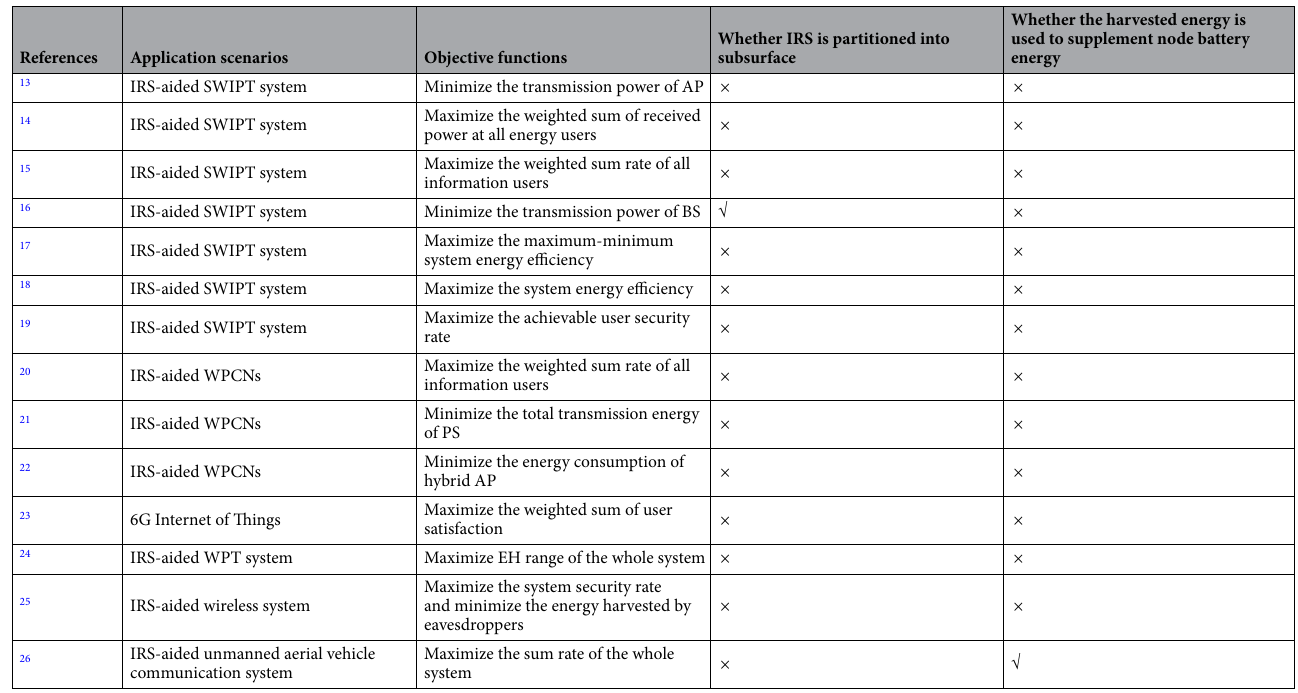
Table 1. Characteristics analysis of related